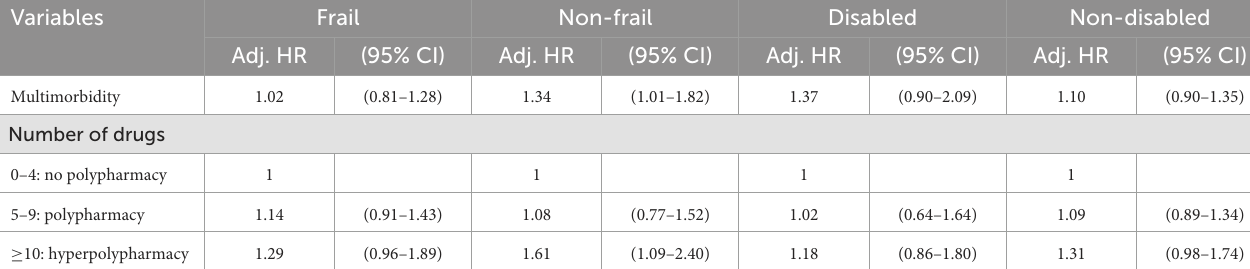
TABLE 3 Predictors of 1-year mortality stratified by frailty and disability status. Variables